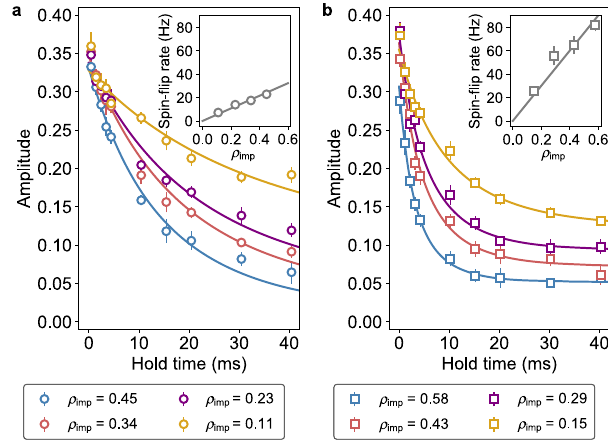
Fig. 5 Magnetic fi eld dependence of transport dynamics. a , b Time evolution of the oscillation amplitude for different magnetic fi elds: a 45 Gauss and b 135 Gauss. Error bars are 1 σ con fi dence intervals of the oscillation amplitude. Solid lines represent the fi ts to the data with Eq. (9). In the data fi ts shown in ( b ), τ in Eq. (9) is treated as a free parameter for the better estimation of the spin- fl ip rate. Each inset shows the spin- fl ip rate as a function of the impurity fraction ρ imp . Error bars are 1 σ con fi dence intervals of the spin- fl ip rate obtained from the data fi ts in ( a , b